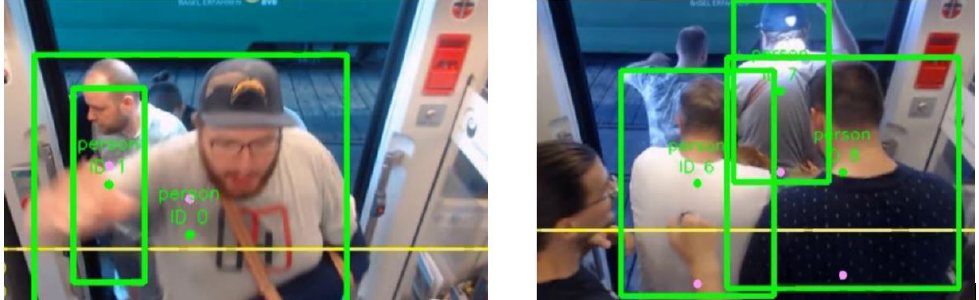
Figure 4. Simulated boarding and deboarding scenarios were performed to measure the accuracy of the newly developed AI as well as the infrared passenger counting